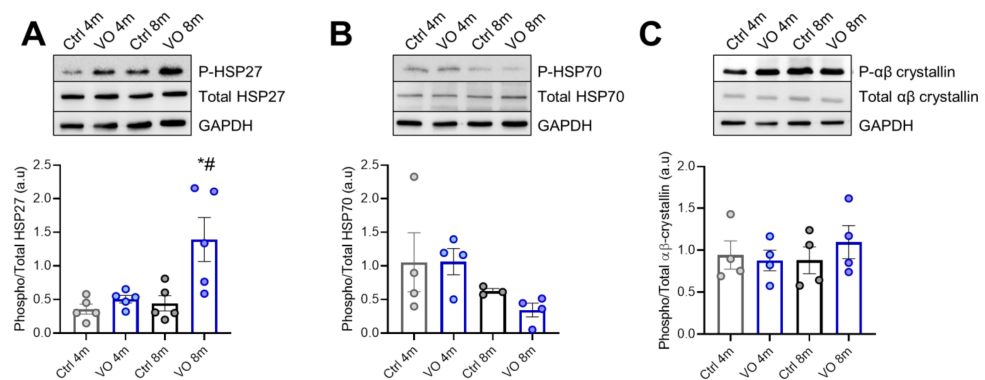
Figure 5. Chaperon proteins of the protein quality control system. ( A ) Phosphorylated/total heat shock protein 27 ratio, ( B ) phosphorylated/total heat shock protein 70 ratio, ( C ) phosphorylated/total αβ -crystallin ratio. Data are shown as mean ± SEM; n = 4–6. * p < 0.05 4-months vs. 8-months, # p < 0.05 Ctrl vs. VO using one-way ANOVA Tukey multiple comparisons